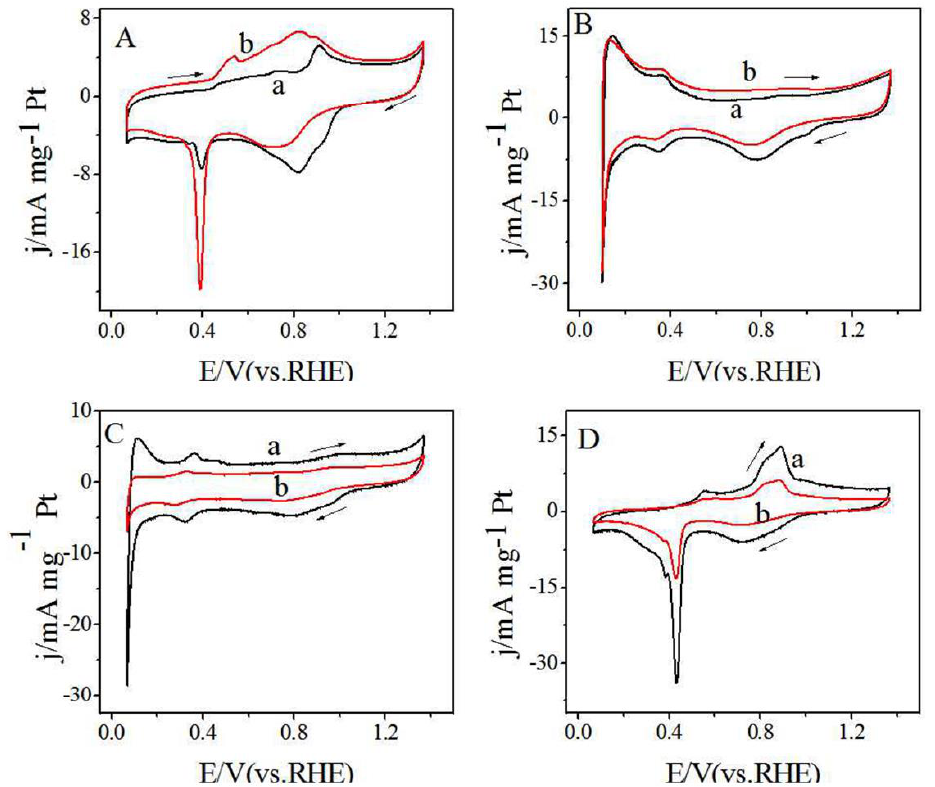
Figure 7. Cyclic voltammetry in 1.0 M NaOH: Pt-Bi (Bi 2 O 3 )/GNs (PVP) ( A ), 30% PtRu/C-JM ( B ), Pt/GNs (PVP) ( C ) and Pt-Bi (Bi 2 O 3 )/GNs ( D ), at 10 mV s −1 , curve a: saturated with oxygen, curve b: saturated with nitrogen.